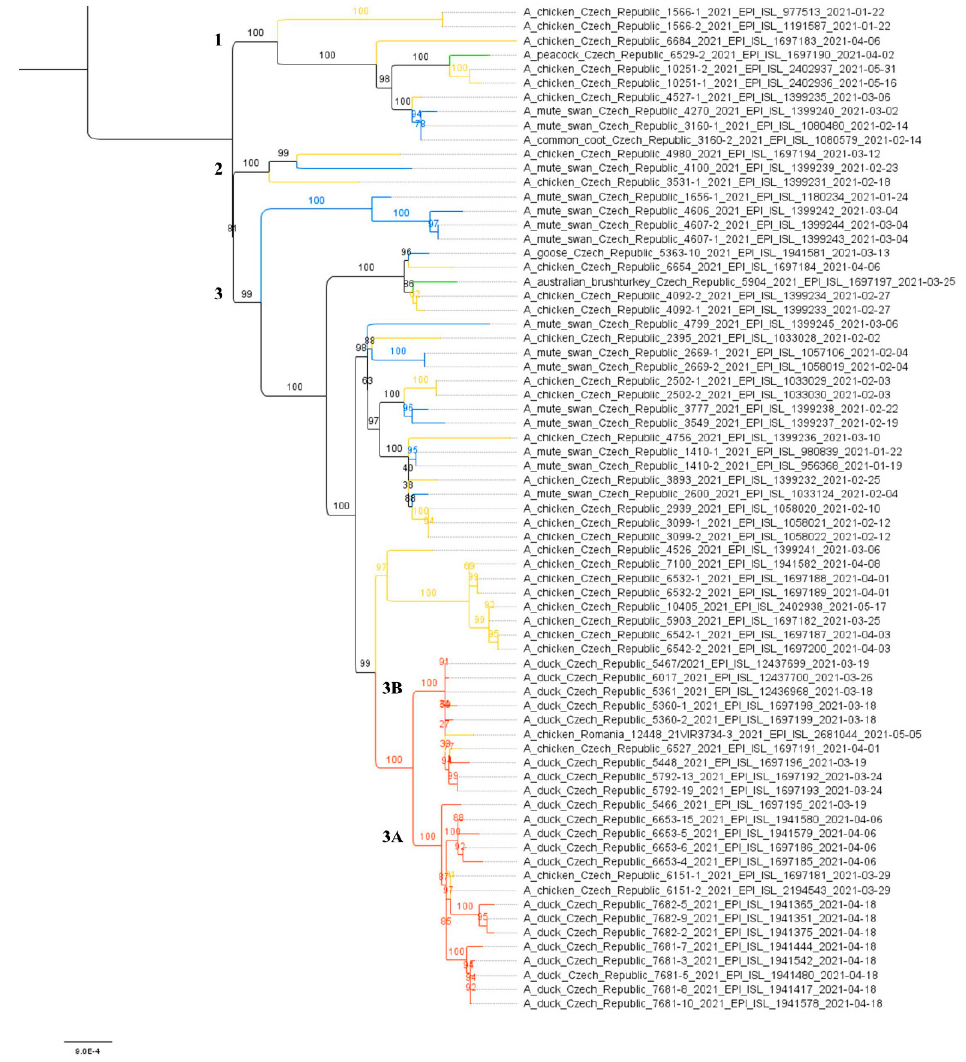
Figure 2. Species correlation tree. The ML tree was calculated on the basis of 70 concatenated CZE/2021 H5N8 genomes using the IQ-TREE (K3Pu + F+G4 as the best fit model selected according to the Bayesian information criterion). The tree was drawn to scale with branch lengths measured in the number of substitutions per site, and the bootstrap values (1000 replicates) were shown in percentages. Tree clades were colored according to origin: red—commercial; orange—backyard; blue—wild; green—hobby/exotic. The subclades are designated with the numbers 1–3. A subtree including H5N8 strains from commercial poultry is shown in more detail in Figure 3.